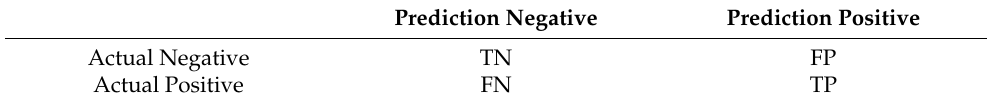
Table 3. Confusion